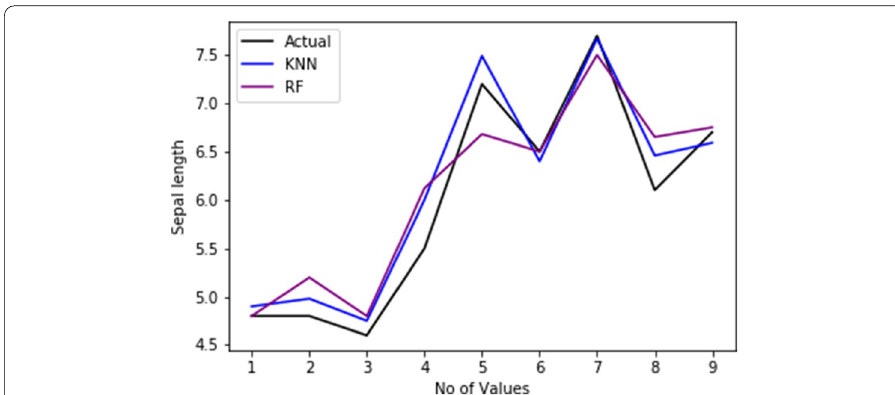
Fig. 2 Comparison of KNN and RF Imputed values with the actual values on Sepal Length at 15% ratio